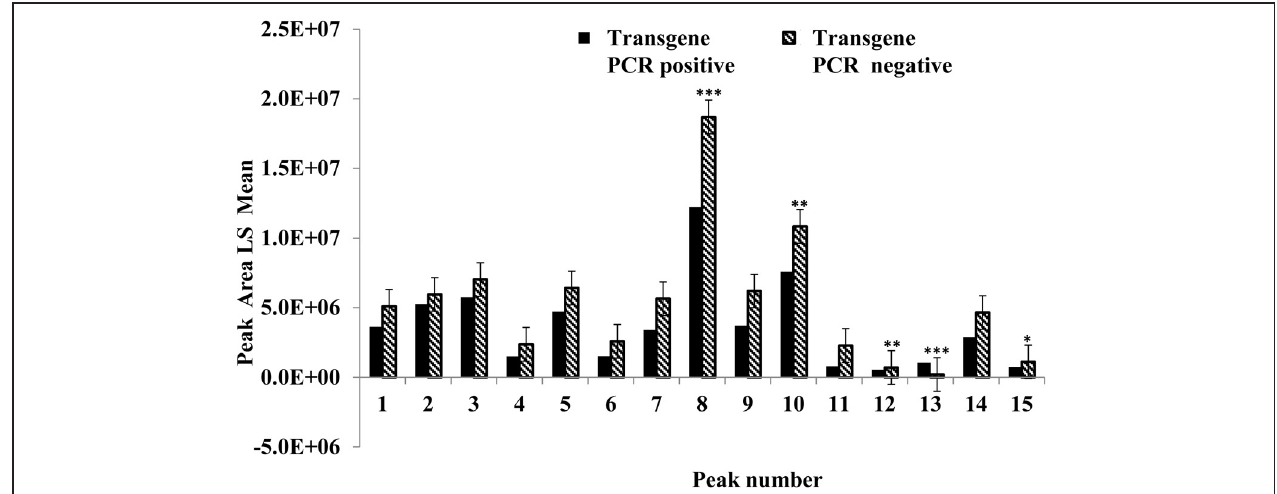
transgene-encoded ferritin PCR positive and negative maize seed samples are indicated with one, two, and three stars on top of each bar to represent significant differences at 5, 1, and 0.1% significance levels, respectively.